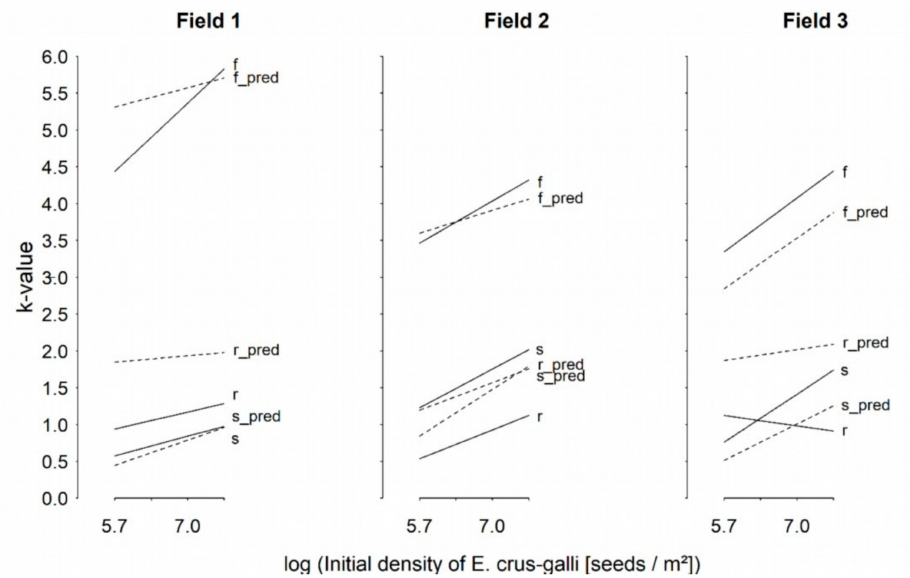
Figure 2. K-values to determine the strength of density dependent mortality for seedling emergence (r), seedling survival (s), and seed production per plant (f) of Echinochloa crus-galli in the presence (“pred”, dashed lines) or absence (solid lines) of seed predation in fields 1, 2, and 3 shown for each log (initial density of E. crus-galli [seeds/m 2 ]). Data predicted by using the models (see Table 1) calculate the k-values per log (initial density of E.crus-galli [seeds/m 2